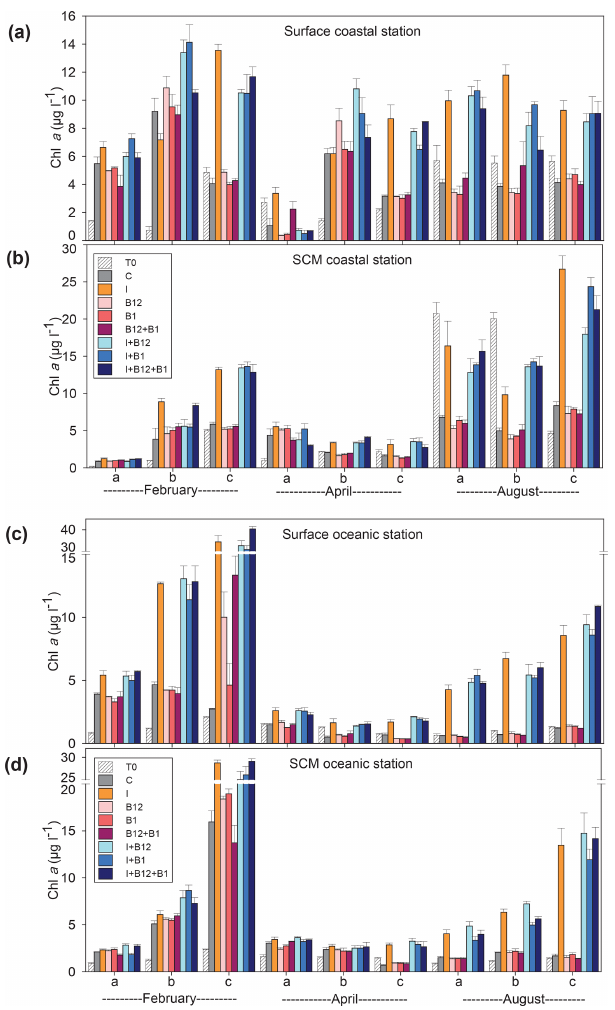
Figure 6. Prokaryote biomass (µg CL − 1 ) in the t 0 of each exper- iment (striped bars) and in the endpoint of each treatment (colored bars) in the experiments conducted at (a) surface and (b) SCM depth in the coastal station and at (c) surface and (d) SCM depth in the oceanic station in February, April and August. Error bars repre- sent standard error. Note that the y axis is broken. SCM: subsurface chlorophyll